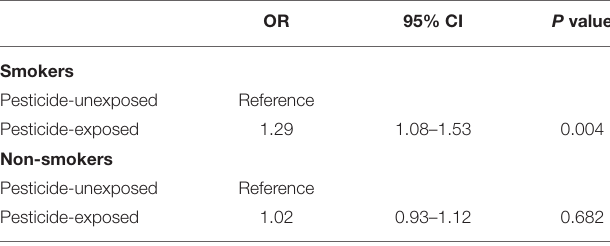
TABLE 3 | Associations between household pesticide exposure and hypertension by smoking status.